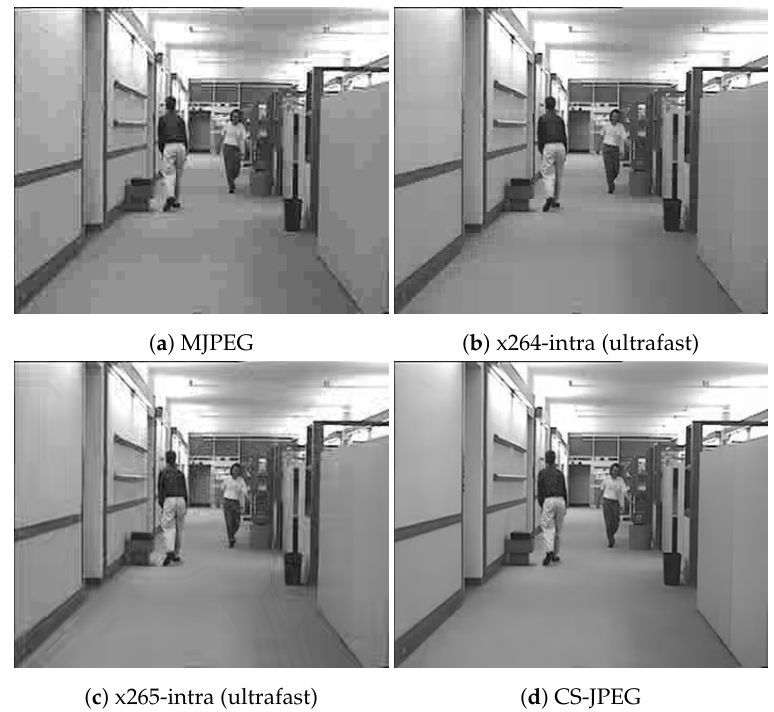
Figure 12. Frame with index 150 at R T = 600 kbps for